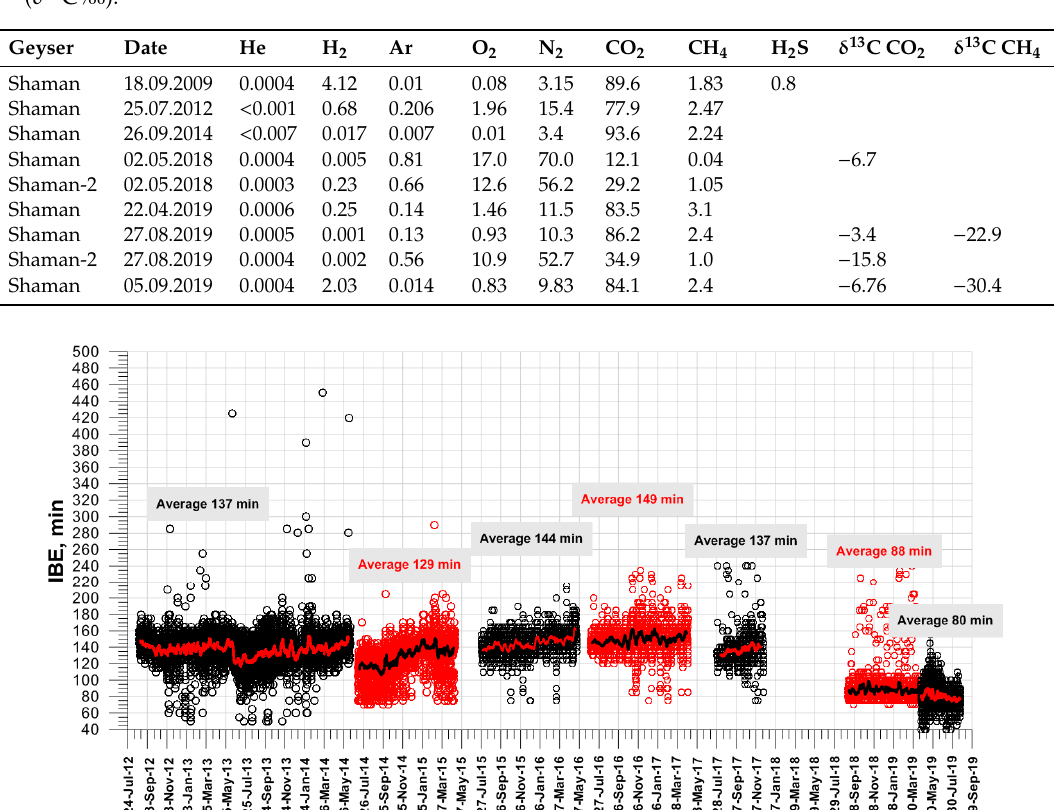
Figure 3. IBE history of the Shaman geyser during the time period from 2012 to 2019. Note: black and red symbols show different times when the temperature loggers were replaced on site.